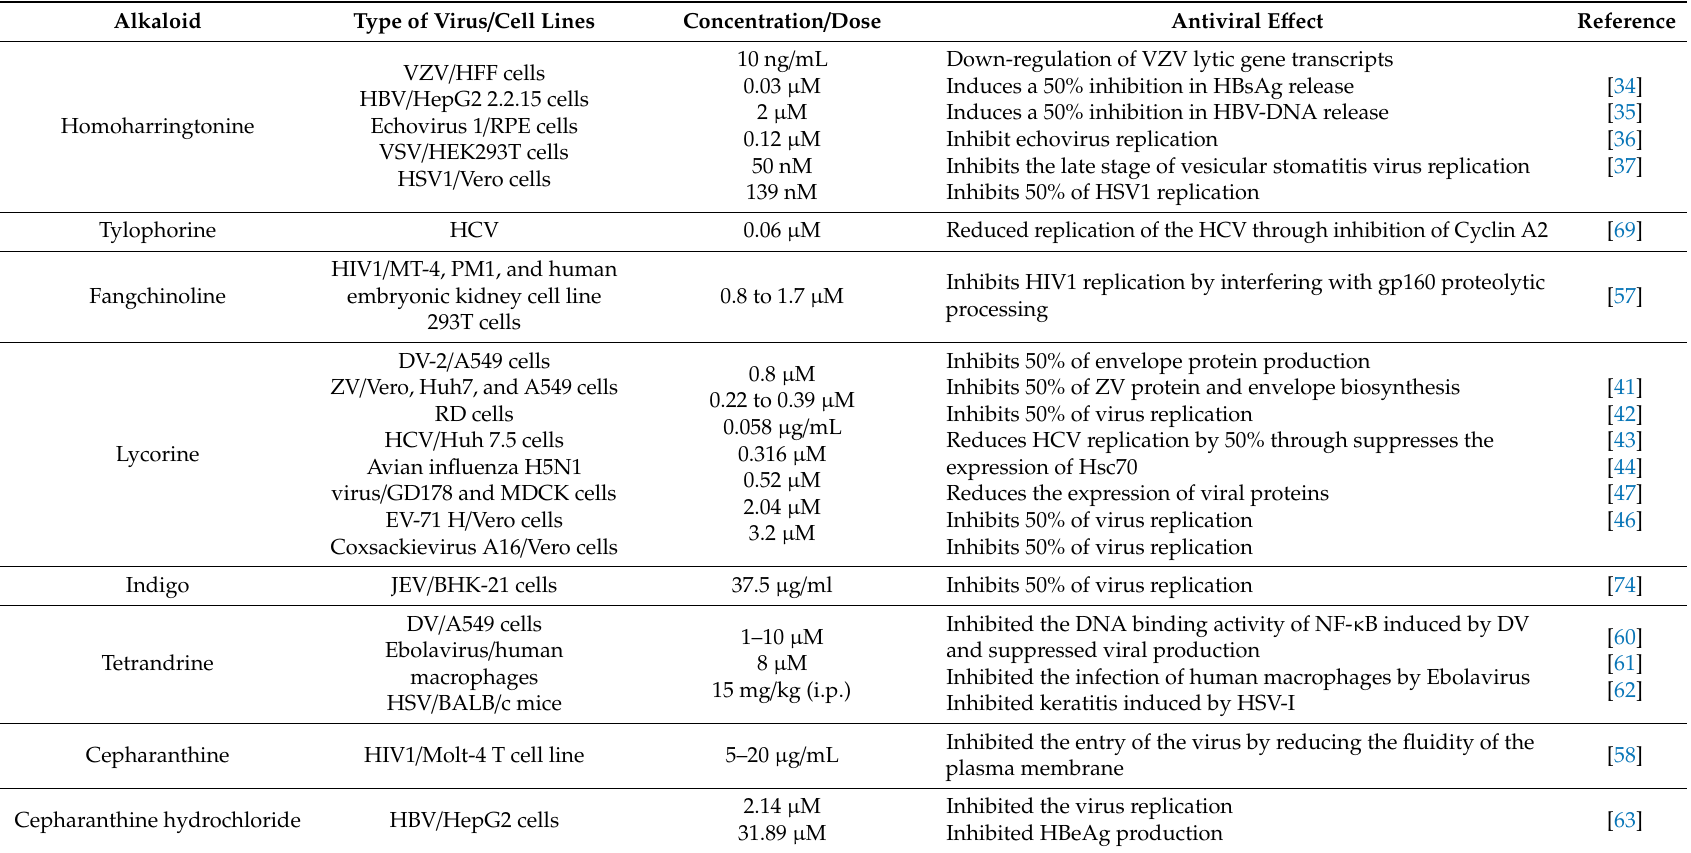
Table 2. Bioactivity of alkaloids against other viruses besides the